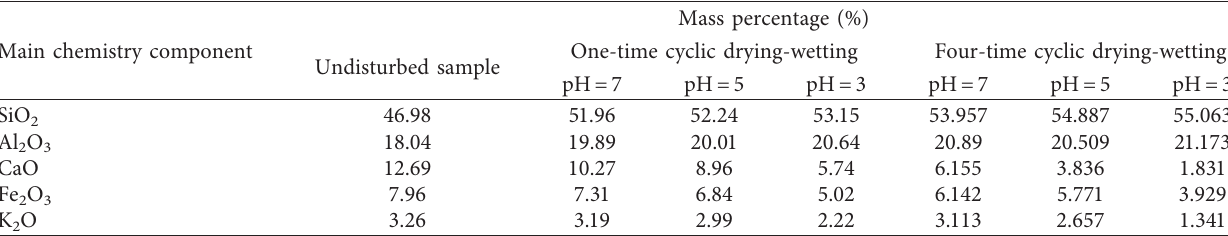
Table 7: Main chemical composition and content of Baise expansive soil.